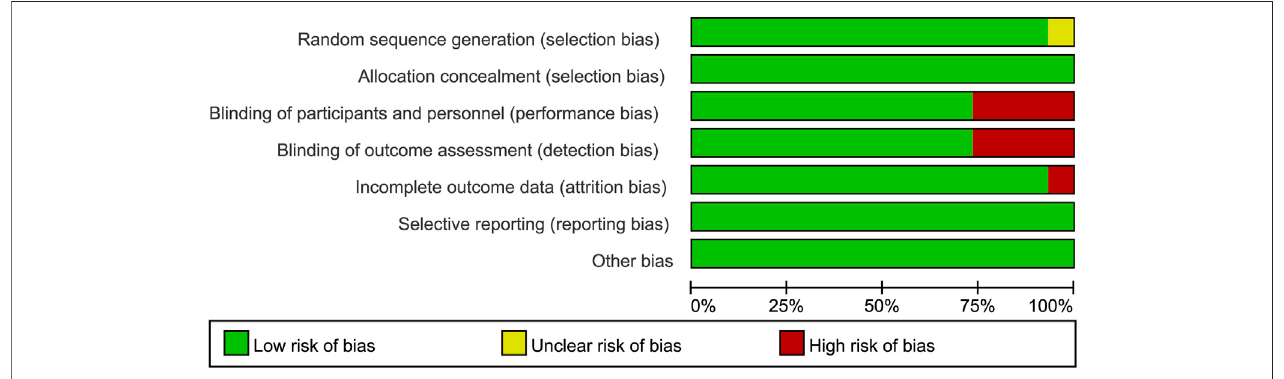
FIGURE 2 | Risk of bias